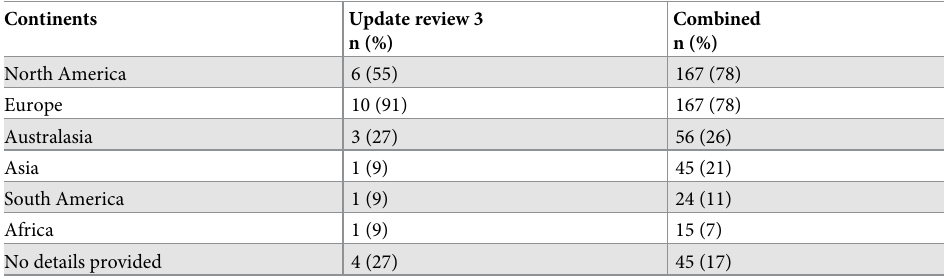
Table 6. Geographical locations of participants included in the development of each COS (n =